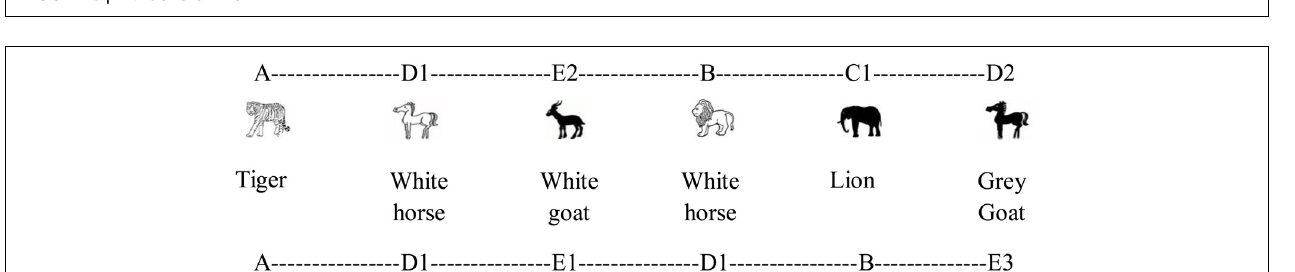
FIGURE 5 | Artificial Grammar 2.